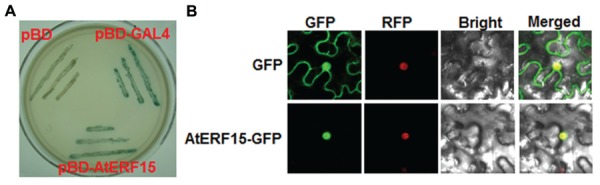
Transactivation activity and nuclear localization of AtERF15 protein. (A) AtERF15 has transactivation activity. Yeast cells carrying pBD-AtERF15, pBD-GAL4 (a positive control) or pBD empty vector (a negative control) were grown on SD/Trp- plates for 3 days at 30°C and activity of β-galactosidase was detected by addition of x-α-gal. (B) AtERF15 is localized in nucleus. Agrobacteria carrying pFGC-Egfp-AtERF15 or pFGC-Egfp empty vector were infiltrated into leaves of Nicotinana benthamiana plants expressing a red nucleus marker protein RFP-H2B and leaf samples were collected at 24 h after infiltration for observation under a confocal laser scanning microscope. Images were taken in dark field for GFP and RFP, bright field for cell morphology and in combination, respectively.